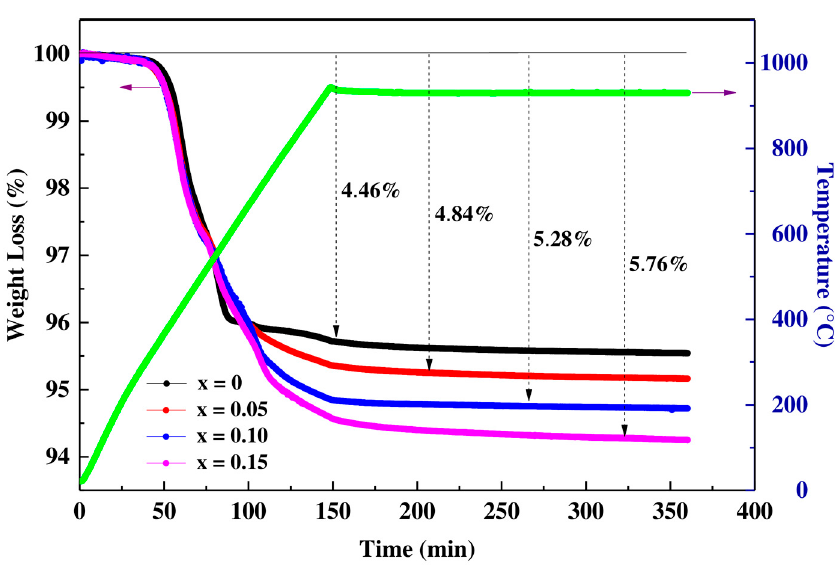
Figure 1. Thermogravimetric analysis of Pr 0.7 Sr 0.3 Mn ( 1 − x ) Co x O 3 samples with (0 ≤ x ≤ 0.15) versus the temperature and time.